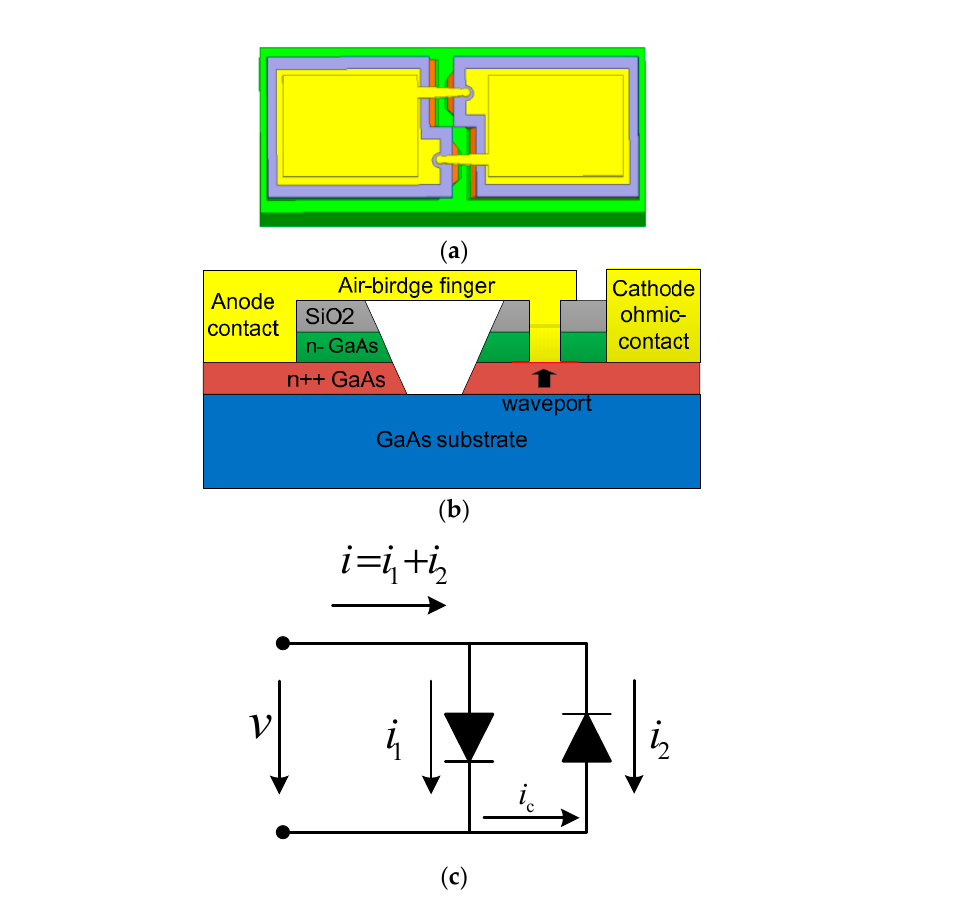
Figure 1. Planar Schottky barrier diode (SBD) chip AP1-G2-0P64: ( a ) 3-D electromagnetic model; ( b ) establishment of Schottky diode wave port; ( c ) Schematic diagram of anti-parallel diodes equivalent circuit.